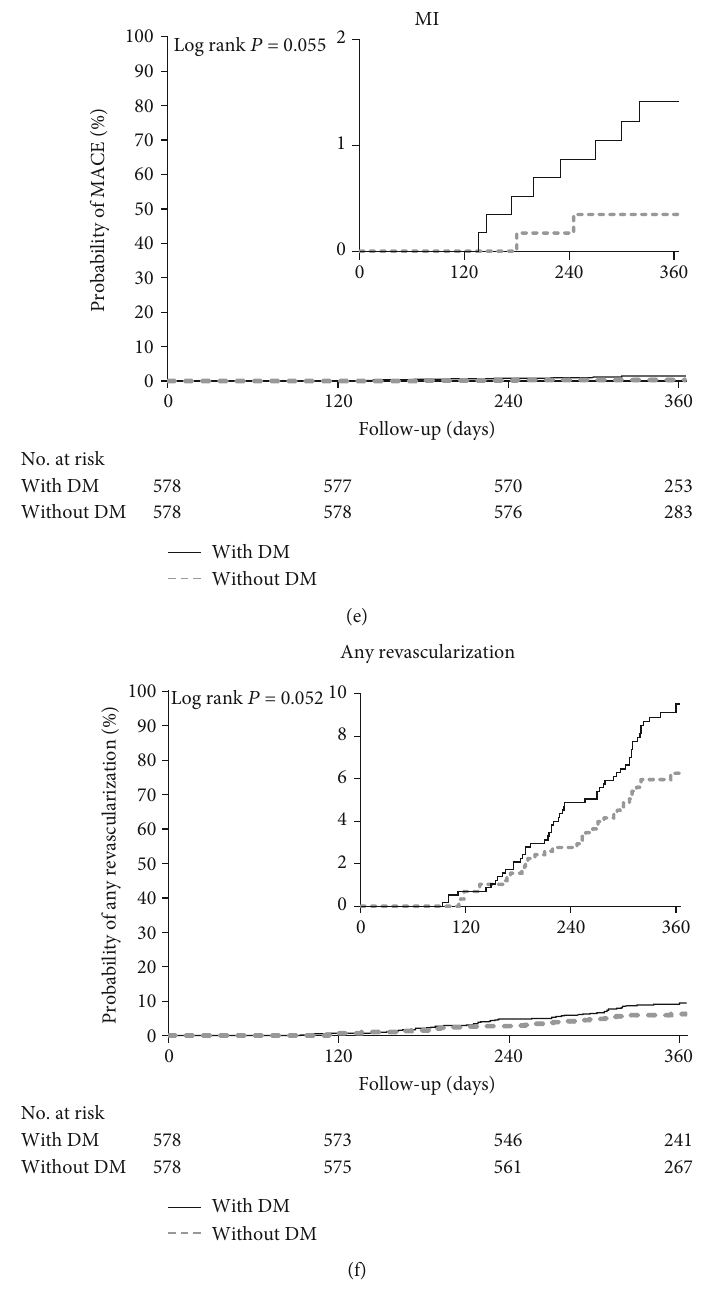
Figure 2: Cumulative risks of the study outcomes in the matched cohort (a), TLF (b), TLR (c), MACE (d), cardiac death (e), And MI (f). In any revascularization, DM: diabetes mellitus; TLF: target lesion failure; TLR: target lesion revascularization; MACE: major adverse cardiovascular events; MI: myocardial infraction. In each panel, the inset shows the same data on an enlarged y